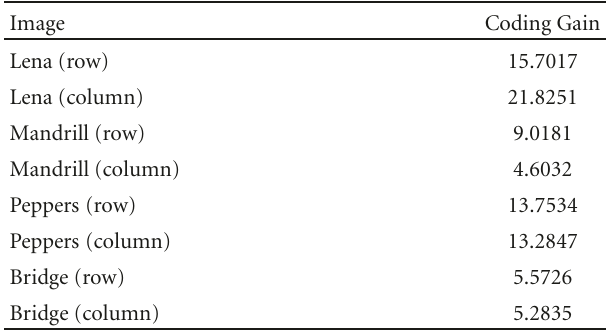
Table 5: Coding gains obtained by Daub-2 filter